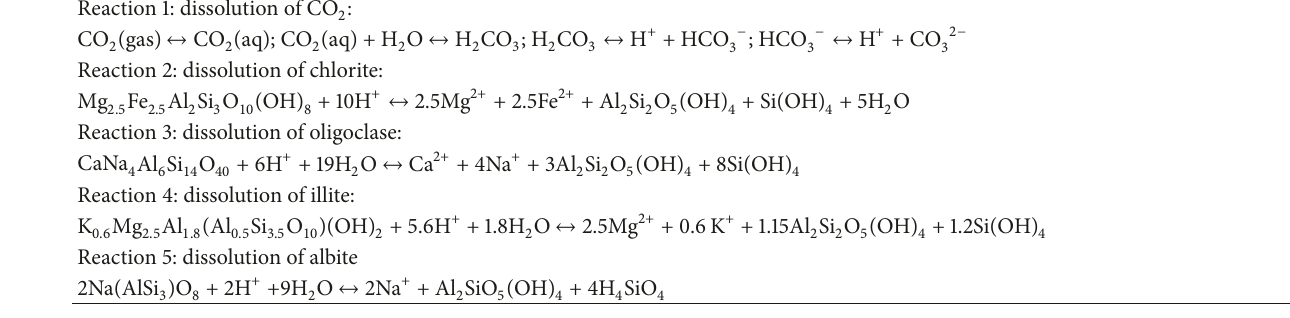
Table 4: The main dissolution reactions in this study.